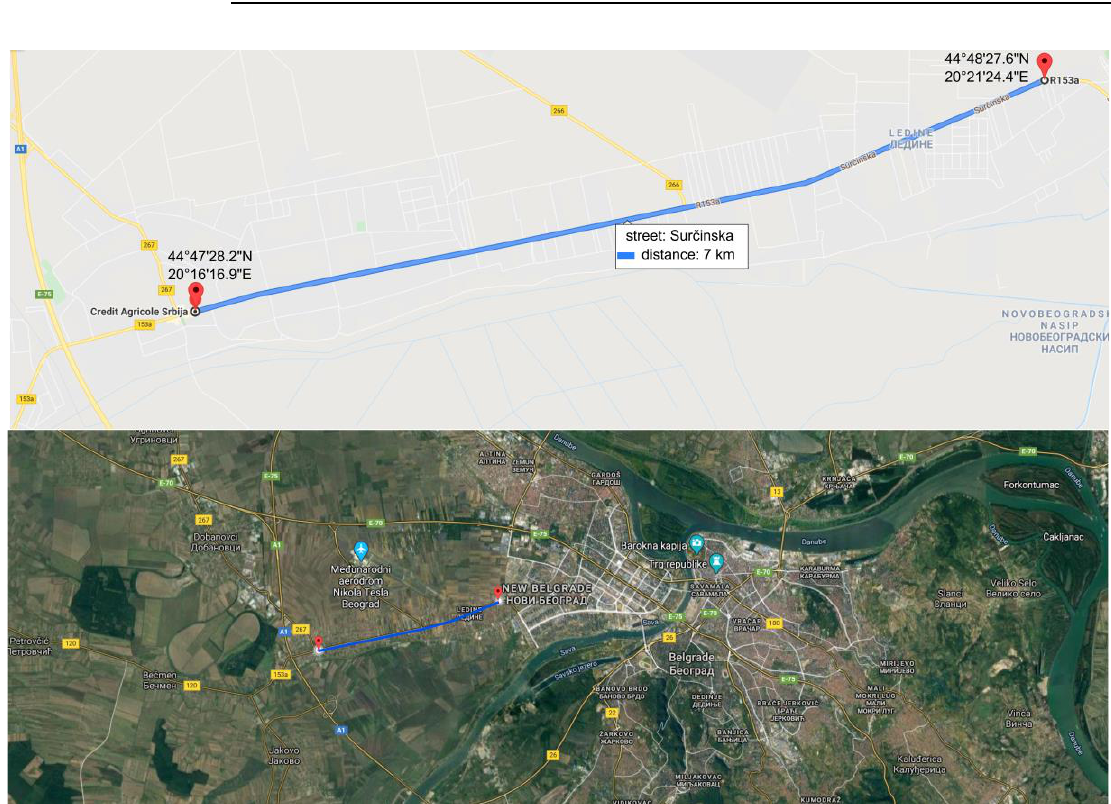
Figure 2. Location of the study area.